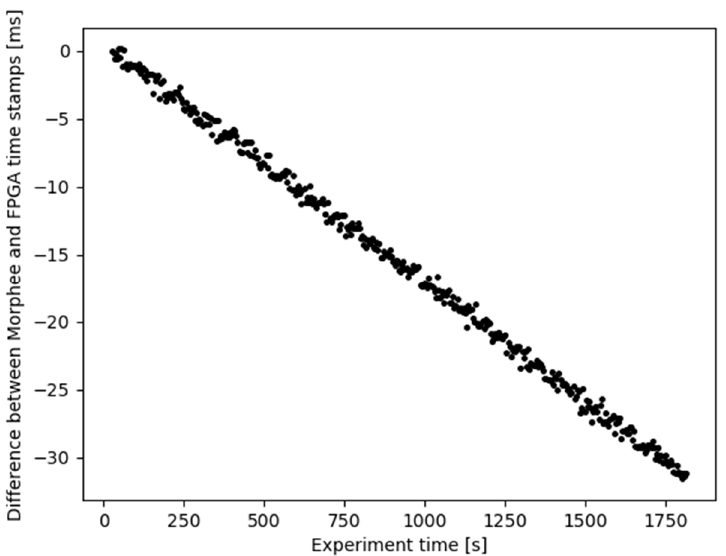
Figure 8. Morphee timestamps relative to FPGA time. Each dot represents one sign detection event.